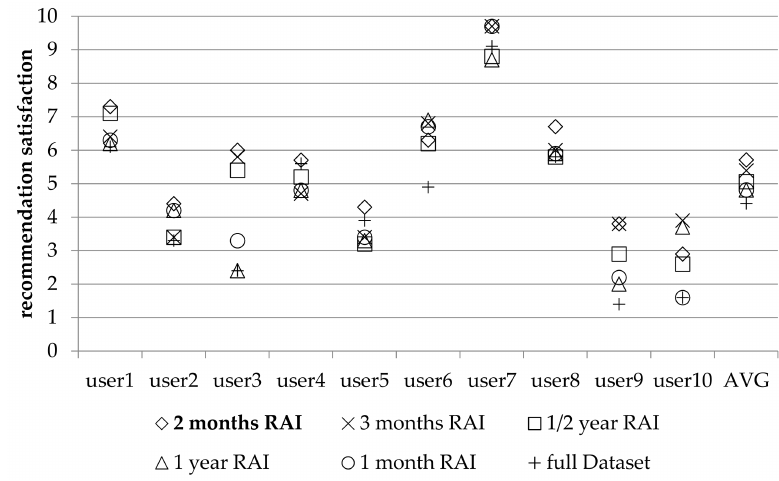
Figure 1. Users’ satisfaction of recommendations made using different RAI variants, when taking into account users’ influencers per